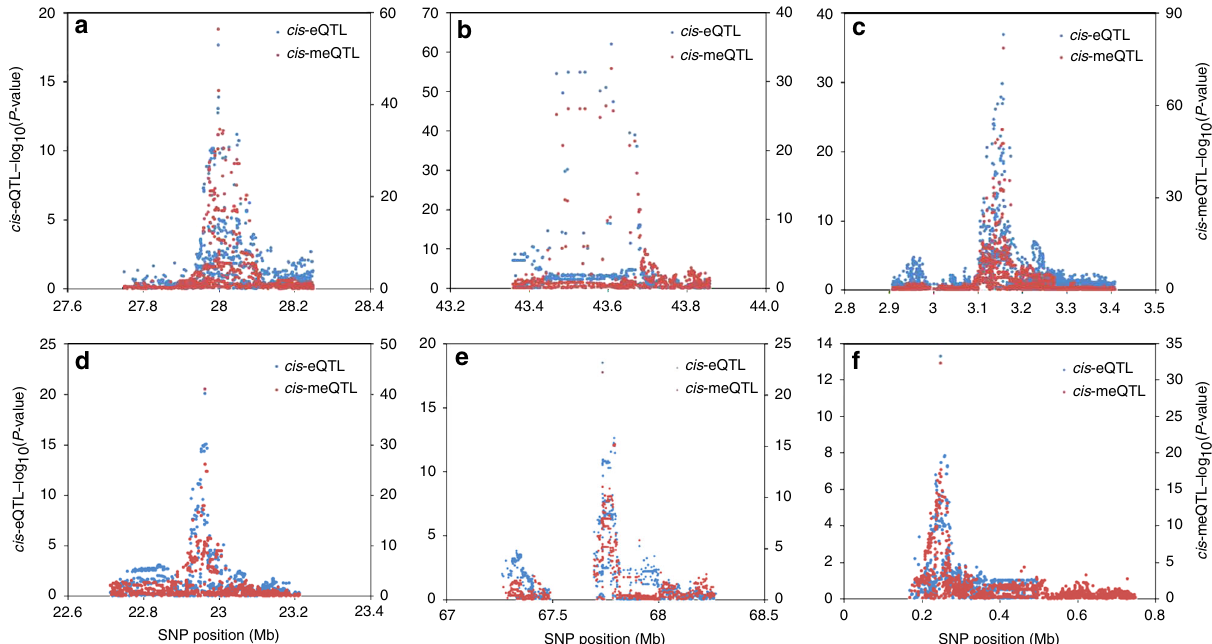
Fig. 3 Examples of six co-localized eQTL-meQTL pairs. P -values for the co-localizing eQTL (blue) and meQTL (red) are plotted against physical position. a ILMN_1658464 ( GTF3A ) and cg22138327. b ILMN_1694711 ( MAD2L1BP ) and cg14302083. c ILMN_1721978 ( CARD11 ) and cg19214707. d ILMN_1737918 ( C1QA ) and cg10916651. e ILMN_2193591 ( UNC93B1 ) and cg20272935. f ILMN_2282366 ( IQSEC3 ) and cg10356759